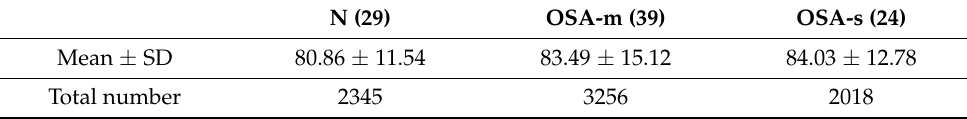
Table 1. Number of 5 min segments in N, OSA-m and OSA-s